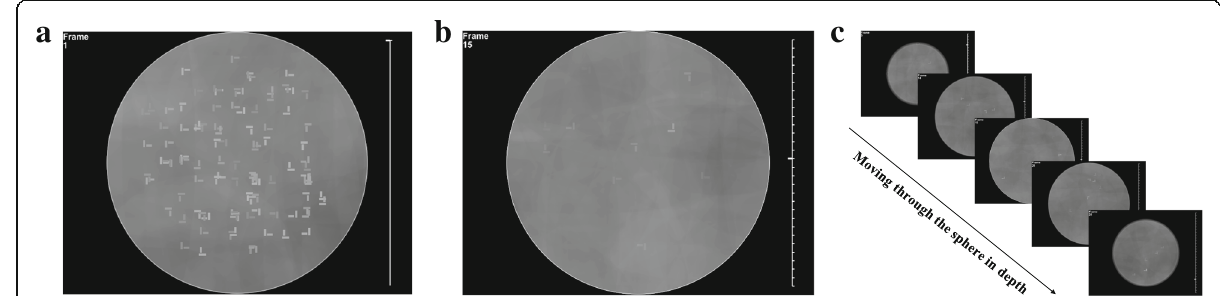
Fig. 1 Experiment 1 ’ s 2D- and segmented-3D-search displays. a Sample stimuli of a 2D-search display where all search items appear in a single “ flat ” plane. b Sample stimuli of a slice in the segmented-3D-search display. Search items were randomly assigned to each slice, and unlike in the 2D display, did not all appear on the same depth plane. c Illustration of how participants could move from slice to slice to search in depth in the segmented-3D